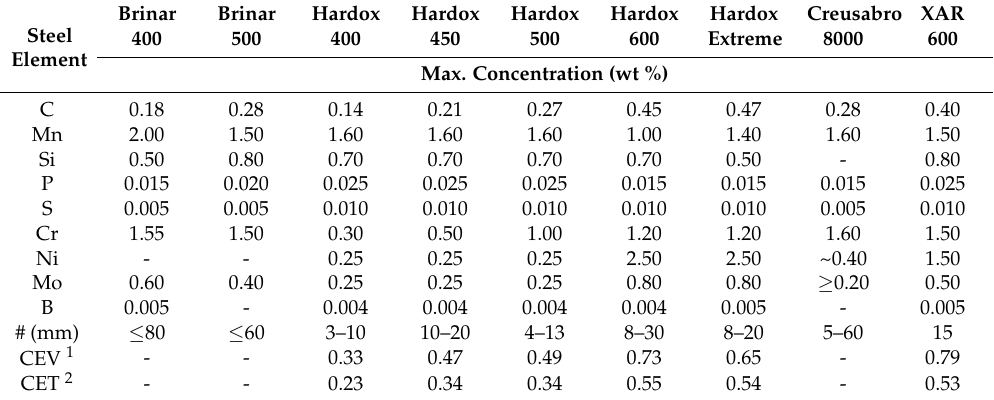
Table 2. Chemical compositions and declared carbon equivalents of selected low-alloy high-strength, abrasive-wear resistant steels